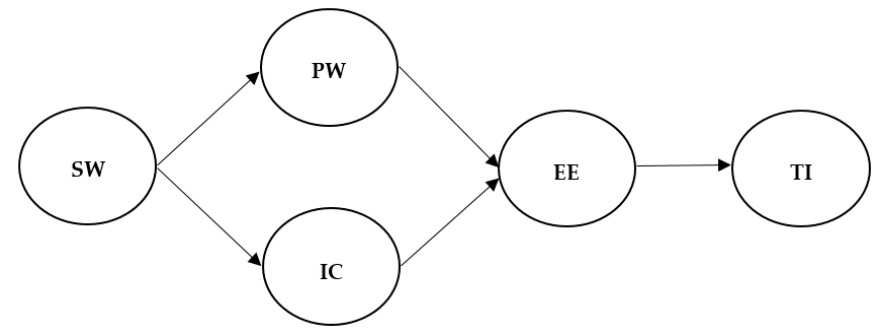
Figure 1. Hypothesized model. Note: SW = supervisors’ workaholism; PW = perceived workload; IC = interpersonal conflict; EE = subordinates’ emotional exhaustion; TI = subordinates’ turnover intention.